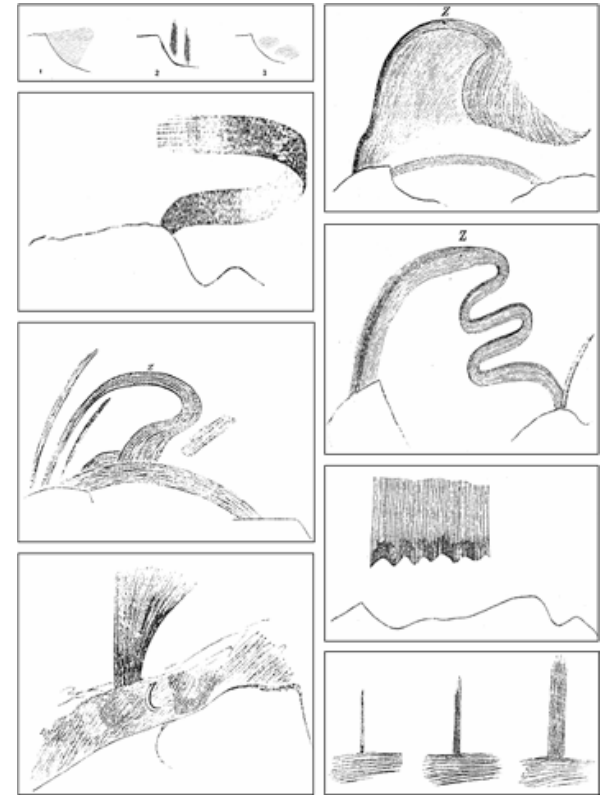
Fig. 6. Sketches of different auroral forms observed by the J. Sykora expedition Figure 6. Sketches of different auroral forms observed by the J. Sykora expedition team.